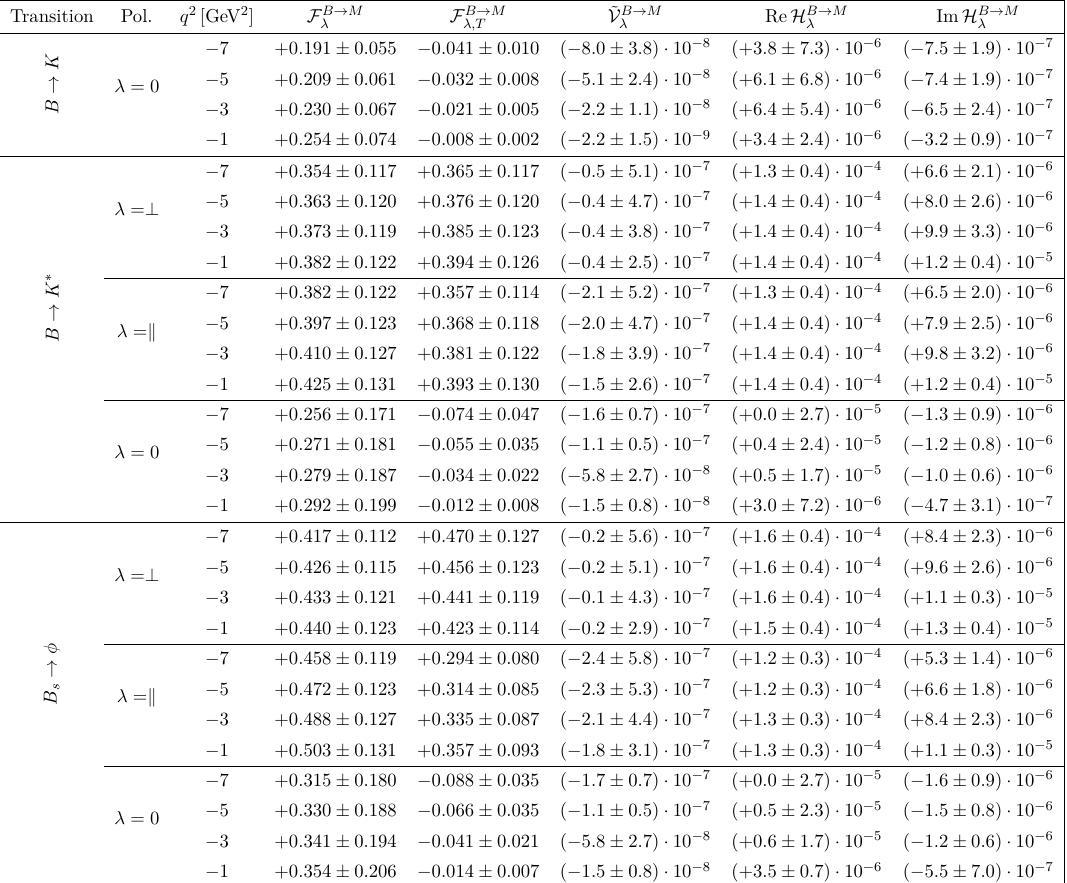
, ˜ V B → M , and H B → M for different values of q 2 λ λ λ, ( T )